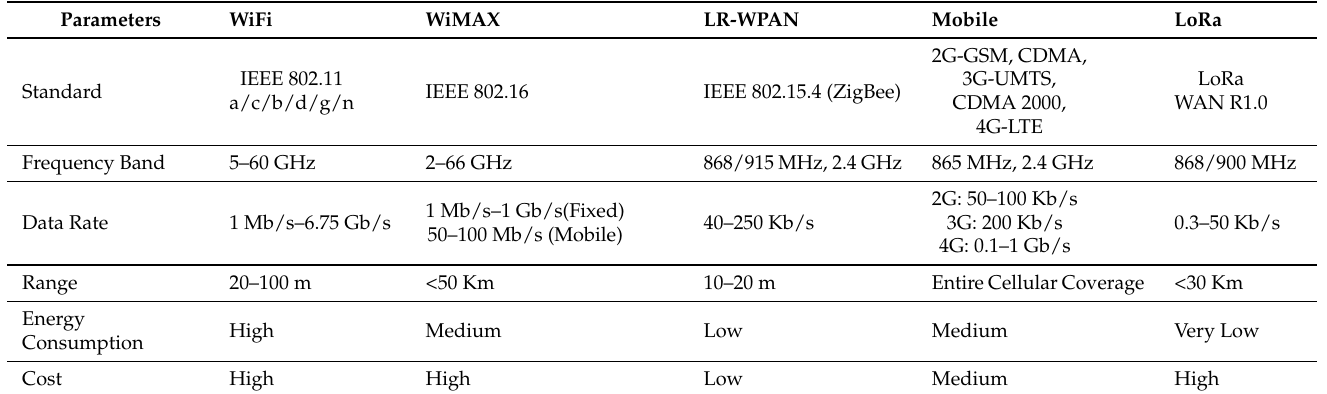
Table 2. Enabling communication technologies for IoT networks [76].